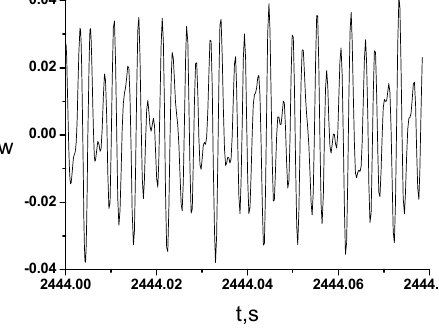
Figure 11. High-frequency oscillations. The scaling factor is equal to 10.6.